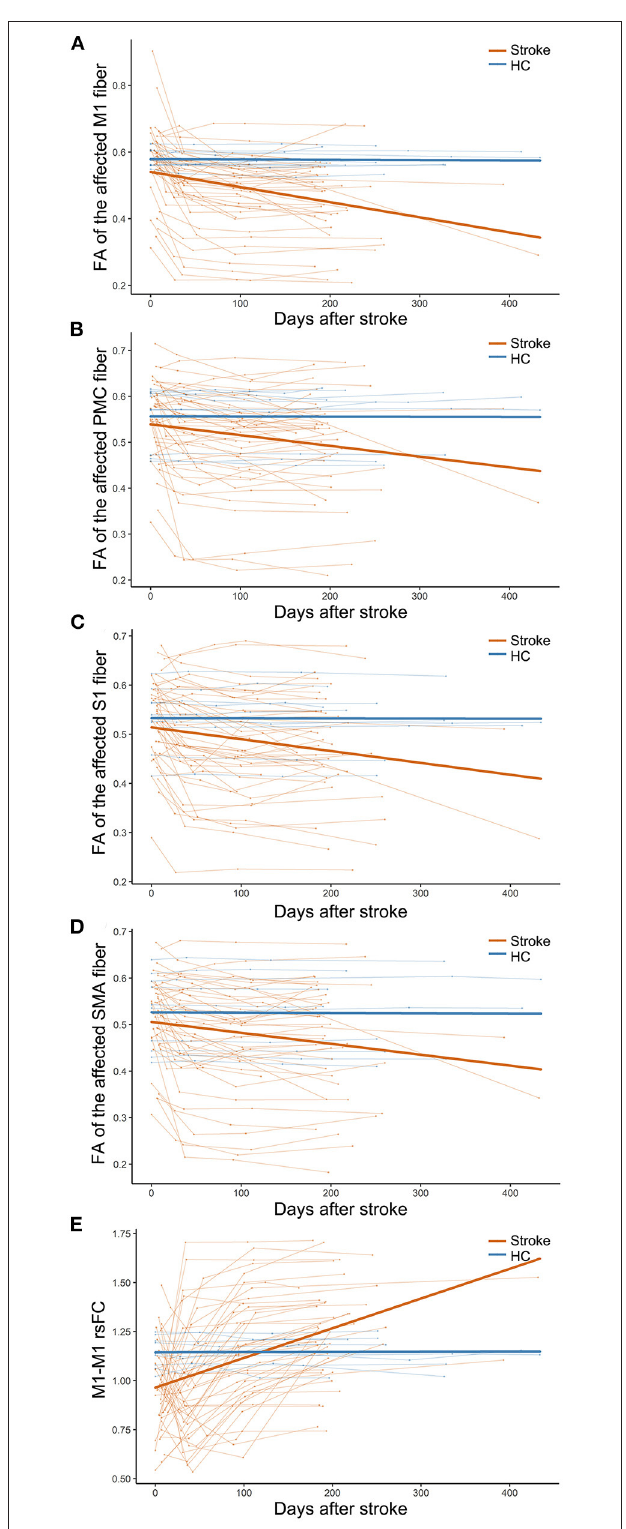
FIGURE 2 | Trajectories of CST and M1–M1 rsFC changes in patients with subcortical stroke. (A–D) Show the longitudinal evolutionary trajectories of the